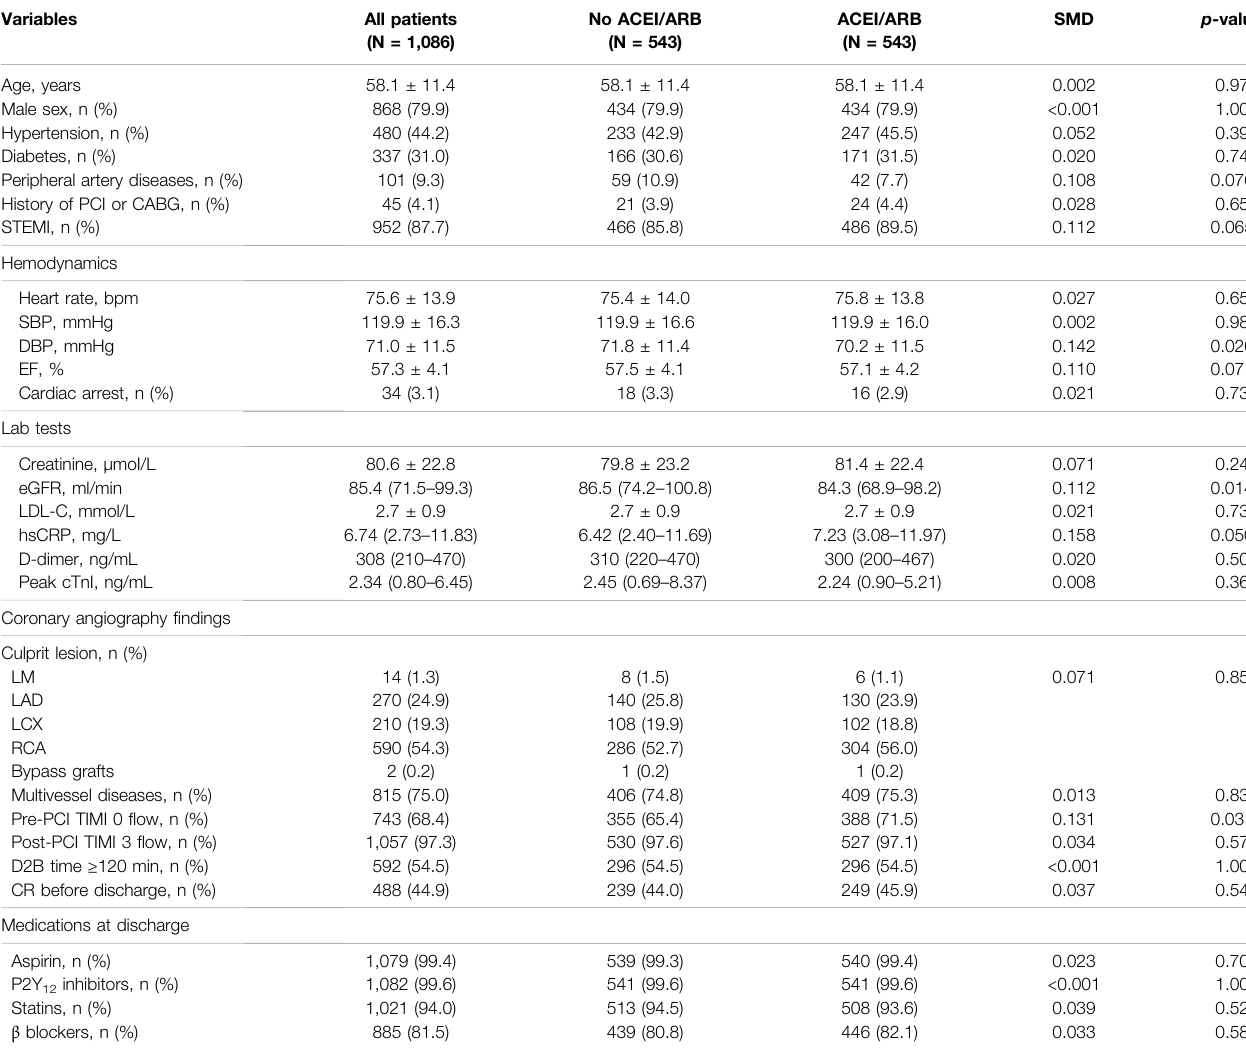
TABLE 2 | Baseline characteristics of patients in the propensity score matching dataset strati fi ed by ACEI/ARB medication.